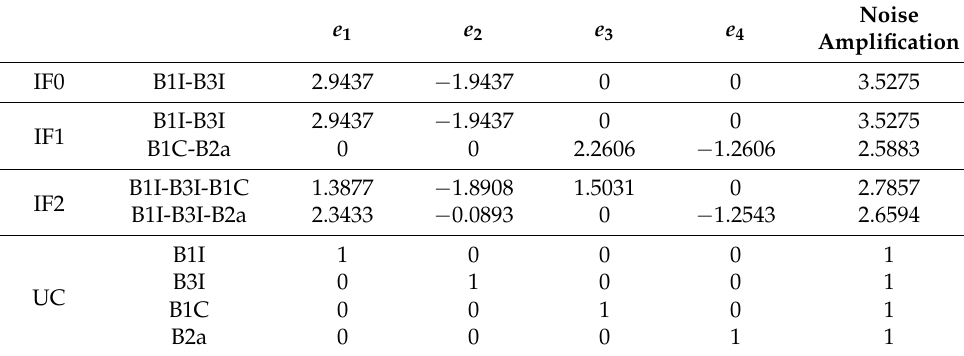
Table 1. Comparison of dual- and four- frequency BDS-3 PPP time transfer models.